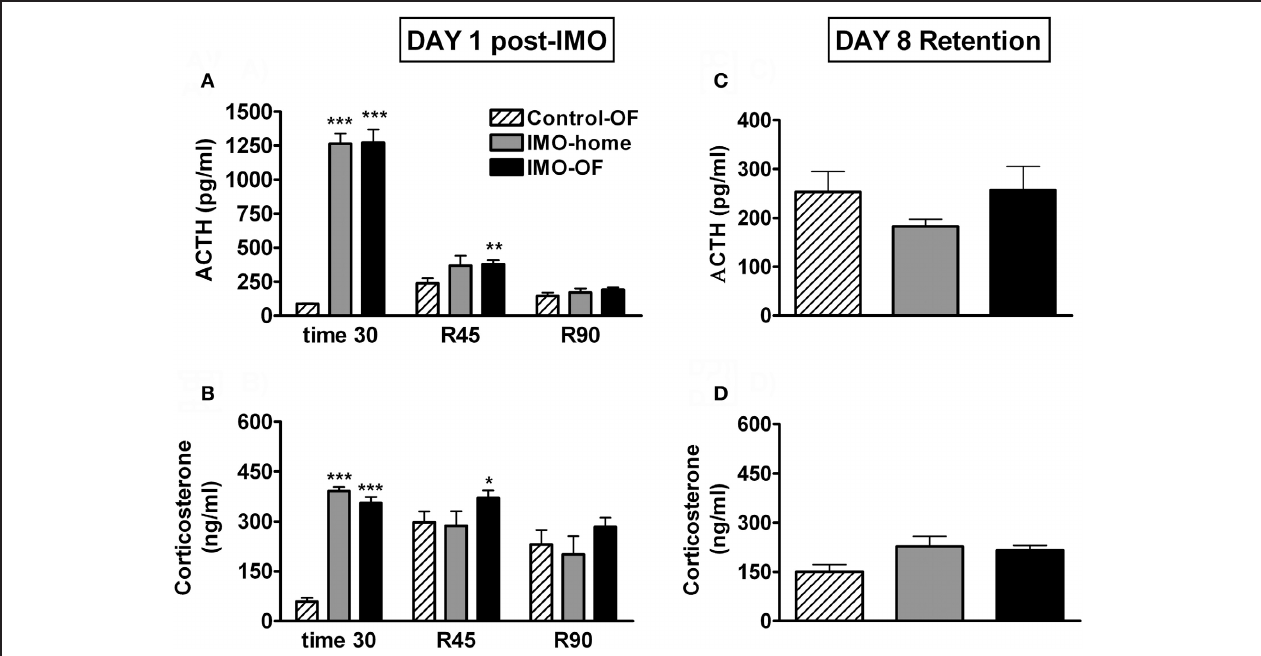
home-cages in the animal room; and IMO-OF groups, which were treated as the previous group but were released from the IMO board and maintained in the same OF for an additional post-IMO period of 90min. Panel (A and B) show hormone levels on day 1, just after IMO (time 30) and at 45 and 90min after IMO (R45 and R90). Panel (C and D) show hormone levels on day 8 (retention). ∗ , ∗∗ , ∗∗∗ : p < 0 . 05, p < 0 . 01 and p < 0 . 001 vs. control-OF